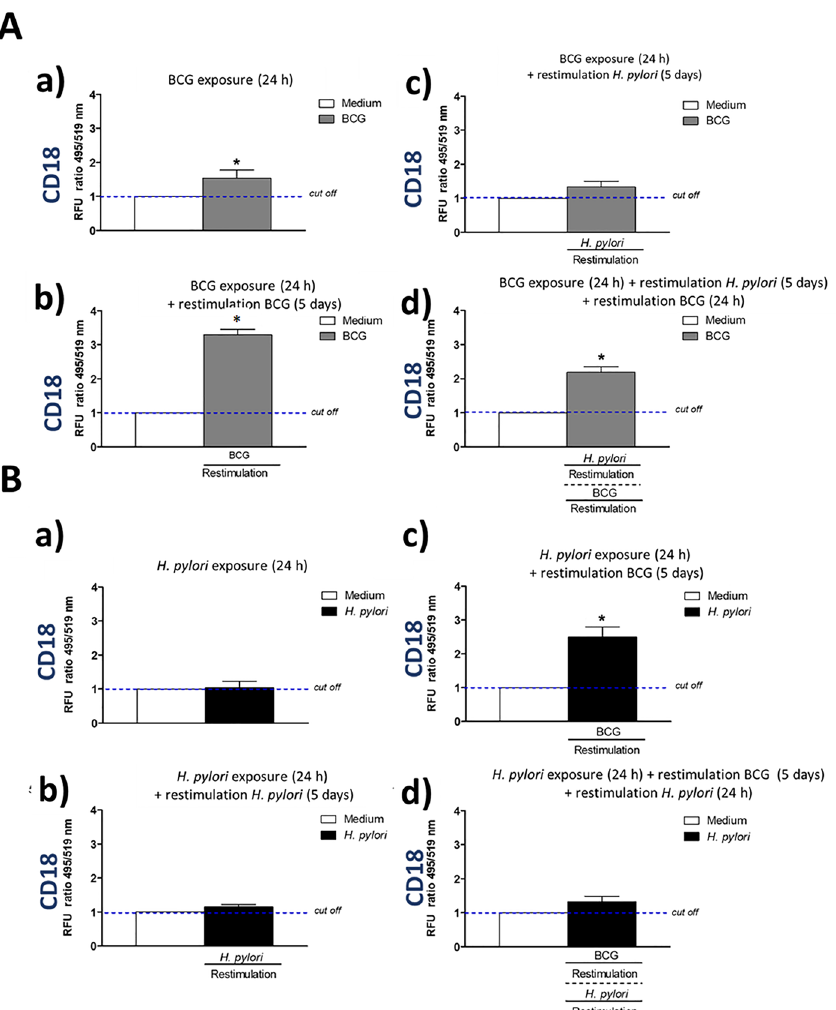
Figure 5. Positive modulation of CD18 expression in THP-1 macrophages by M. bovis BCG. Cells were primed with M. bovis BCG or H. pylori and then underwent restimulation with homologous or heterologous microbial agent. THP-1 cells primed with M. bovis BCG ( A ): cells primed for 24 h with M. bovis BCG (a); cells primed for 24 h with M. bovis BCG and restimulated for 5 days with M. bovis BCG (b); cells primed for 24 h with M. bovis BCG and restimulated for 5 days with H. pylori (c); cells primed for 24 h with M. bovis BCG then restimulated for 5 days with H. pylori and for an additional 24 h with M. bovis BCG (d). THP-1 macrophages primed with H. pylori ( B ): cells primed for 24 h with H. pylori (a); cells primed for 24 h with H. pylori and restimulated for 5 days with H. pylori (b); cells primed for 24 h with H. pylori and restimulated for 5 days with M. bovis BCG (c); cells primed for 24 h with H. pylori , restimulated for 5 days with M. bovis BCG and an additional 24 h with H. pylori (d). The above variants of cells were stained using the fluorescently labeled specific anti-CD18 antibodies. Results are presented as median fluorescence units (RFU) ratio ± range of three independent experiments. The difference statistically significant when p < 0.05 in Mann–Whitney U test. BCG or H. pylori MOI